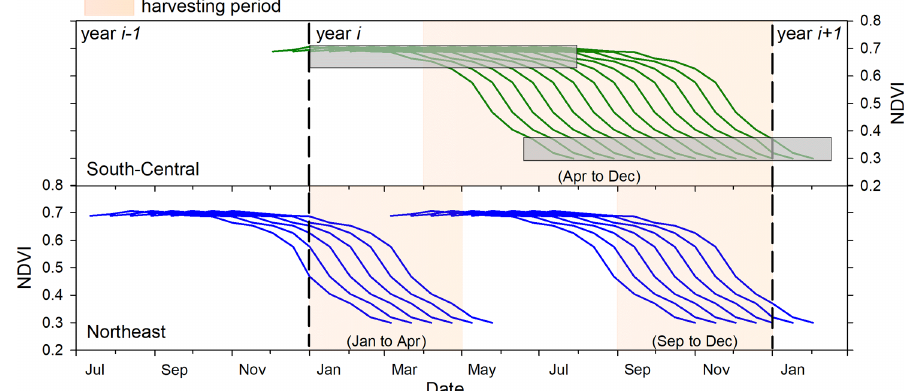
Figure 7. Seasonal changes in the NDVI series for sugarcane in south-central and northeast Brazil. The grey areas are the periods used to calculate the difference between the maximum NDVI value in the growing season (NDVI max ) and the minimum NDVI value in the non-growing season (NDVI min ).